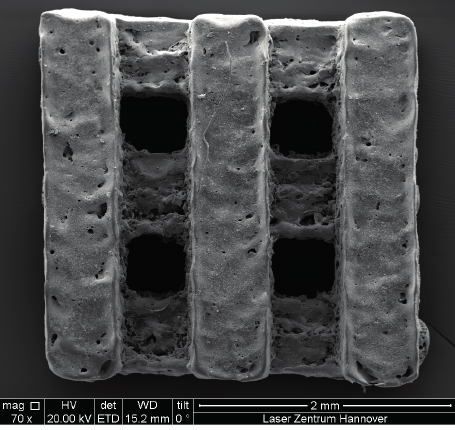
Figure 1. ESEM micrograph of magnesium implant manufactured by selective laser melting